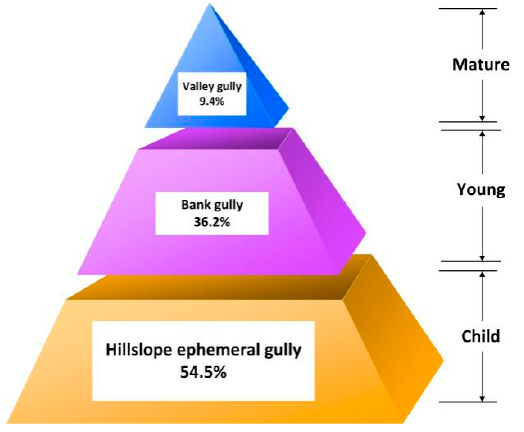
Figure 7. Expansive age pyramid of the gully system.